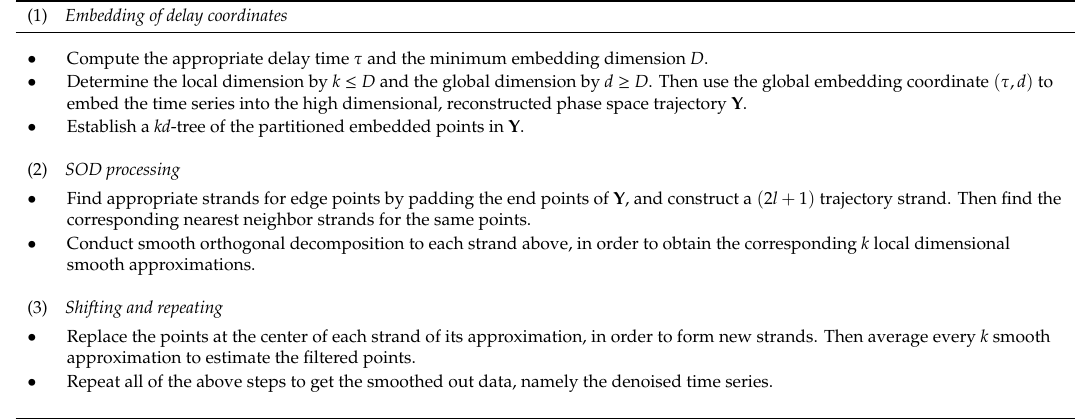
Table 1. The main steps of the smooth local subspace projection